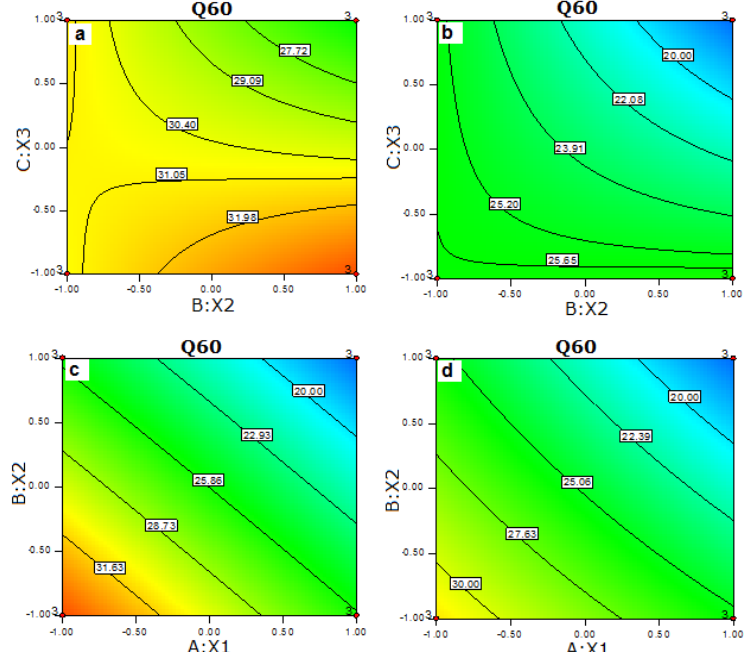
Figure 4. Contour plot of Q 60 a) X 1 at low level, b) X 1 at high level, c) X 2 at high level and d) X 3 at high level.